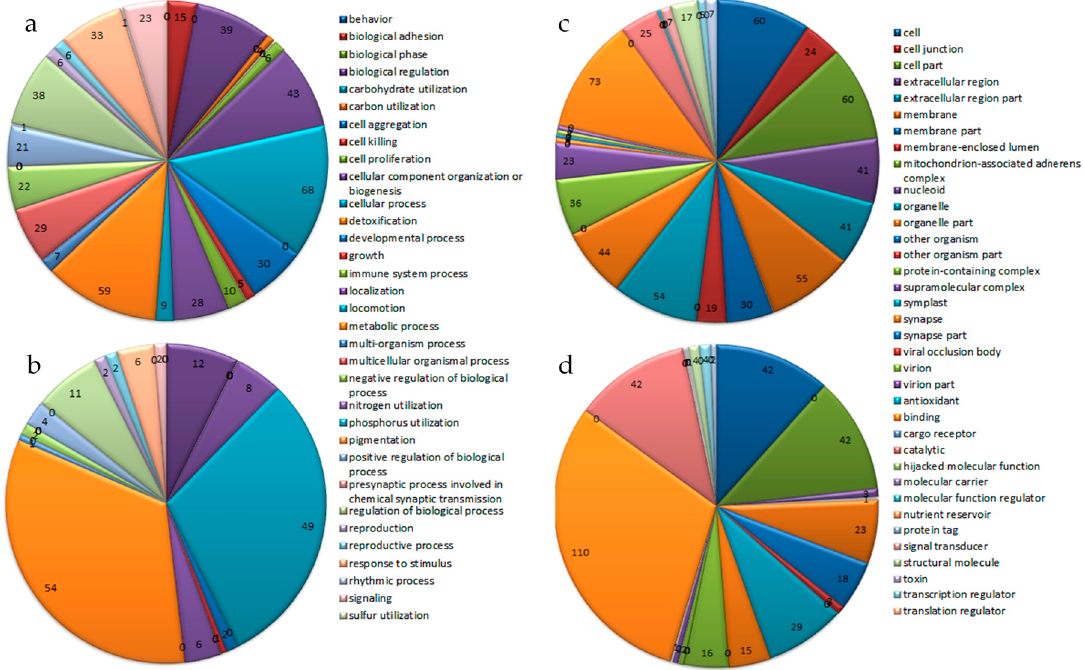
Figure 2. Gene ontology (GO) annotation of endemic genes in the two monospores of Morchella importuna . ( a , b ) Biological process classification; ( c , d ) Cellular component and molecular function classification; ( a , c ) represent the M04M24 strain; ( b , d ) represent the M04M26 strain.